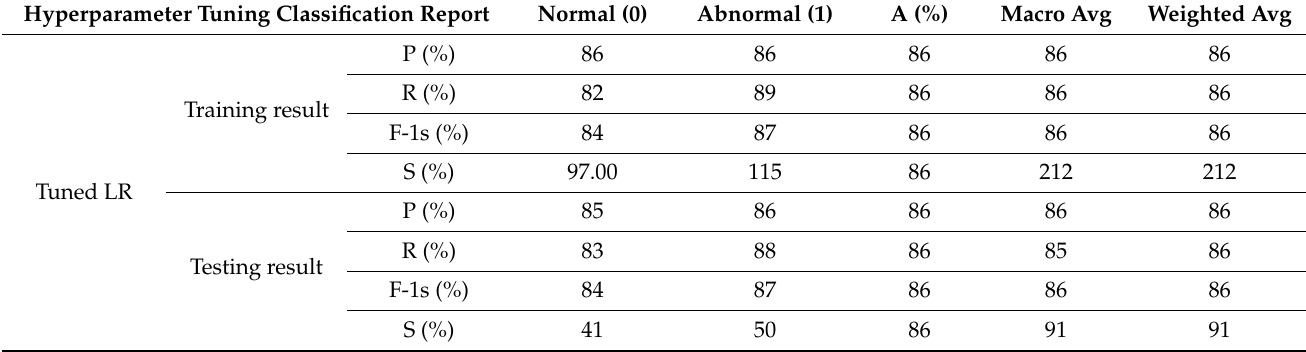
Table 6. The classification report of models using the training and testing datasets compared with a hyperparameter tuning strategy.